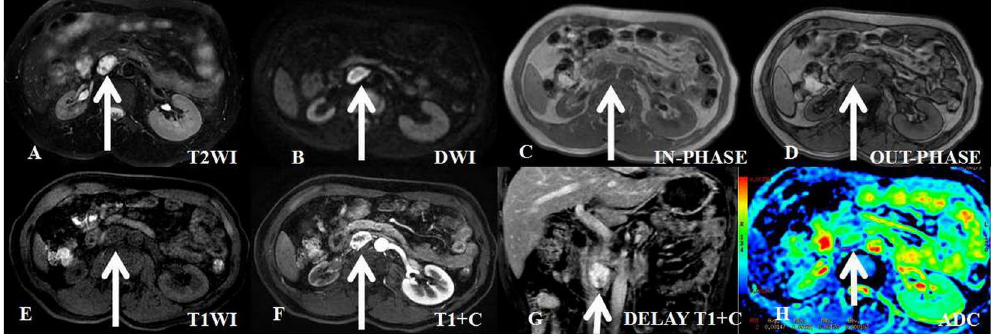
Figure 1. A 49-year-old asymptomatic man with incidentaloma and a histologically proven benign retroperitoneal paraganglioma at the right prevertebral region (between the inferior vena cava and aorta). The transverse and longitudinal diameters of the tumor are 2.61 cm and 3.13 cm, respectively. ( A ) in axial T2-weighted imaging, the tumor demonstrates high signal intensity and isointensity compared with the gluteal muscles. The intratumoral cystic areas exhibit higher signal intensity. ( B ) In axial DWI, the tumor exhibits ring-shaped high signal intensity. ( C – E ) T1-weighted imaging (in-phase, out-phase and pre-scanned imaging, respectively); the signal of the tumor is slightly lower than that of the gluteal muscle. ( F ) In contrast T1-weighted imaging during the arterial phase, the tumor is clearly enhanced and non-homogeneous. ( G ) In coronal T1-weighted imaging during the delay phase, the tumor is clearly enhanced and non-homogeneous. ( H ) ADC imaging; the mean ADC value of the ROI of the tumor is 0.00147 mm 2 /s.